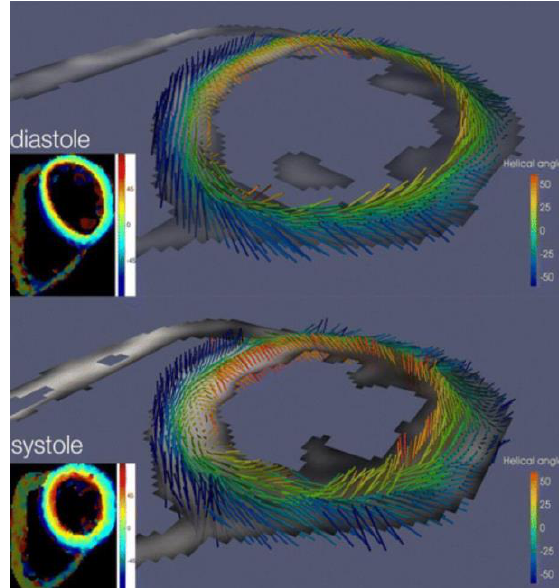
Figure 3. 3D representation of HA (primary eigenvector) in diastole and systole showing a progression of myocytes from a left handed helix in the epicardium (blue), to circumferential in the mesocardium (green) to a right handed helix in the endocardium (red-yellow).